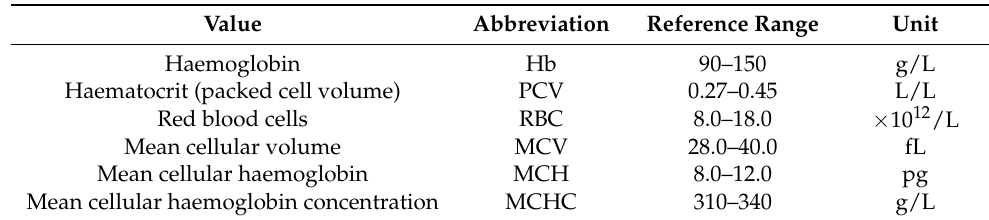
Table 1. Normal haematological reference range values for sheep, adapted from [50]. JOHN WILEY AND SONS LICENSE TERMS AND